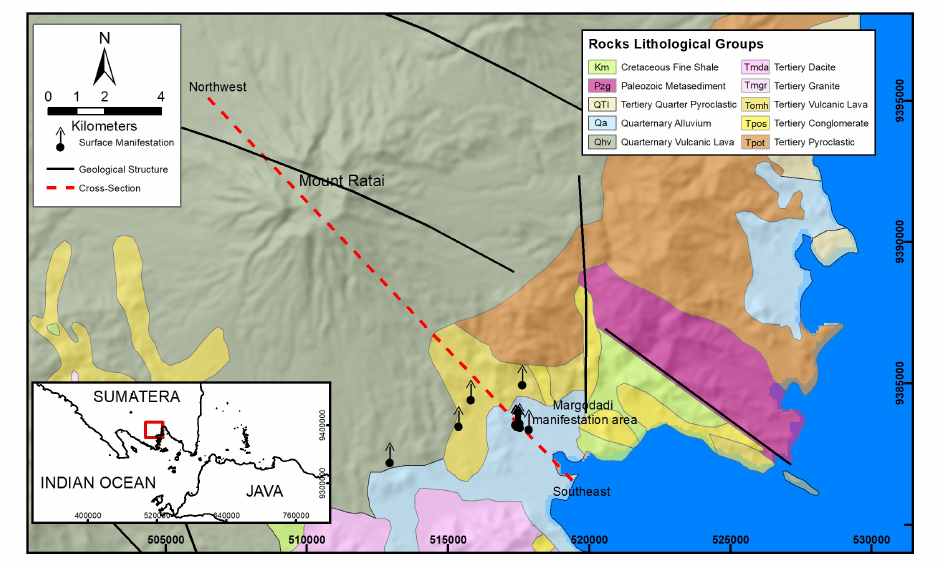
Fig. 1. Map of the regional geological conditions of Way Ratai and the location of surface manifestations. Dashed red-lines are showing a cross-section of simulation model used from modification of the regional geological map of Tanjung Karang